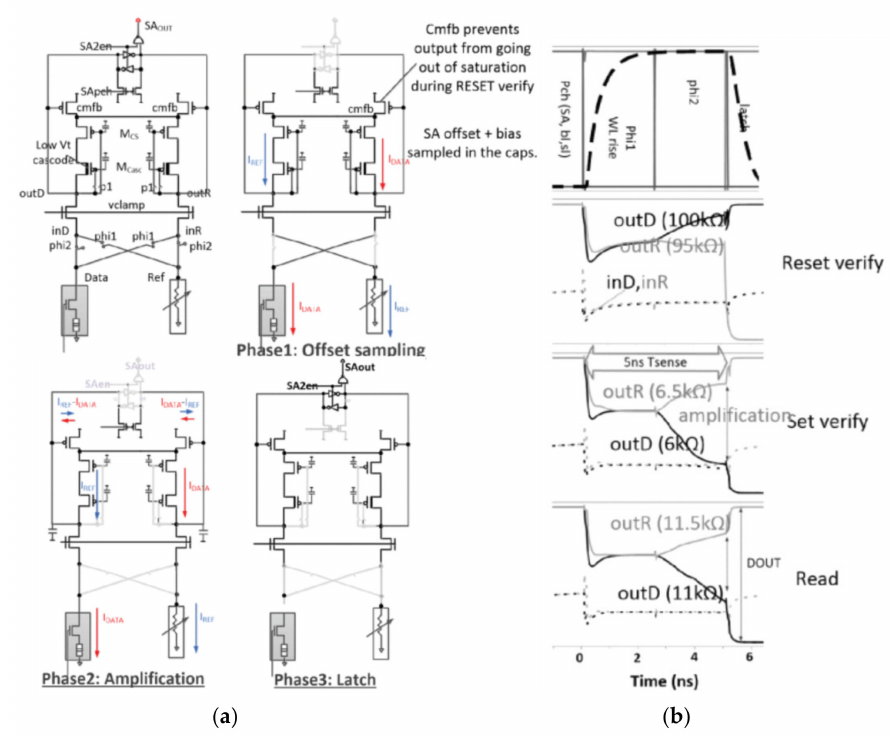
Figure 10. ( a ) OC-CSA in different phases; ( b ) example read, set, and reset-verify simulations [82]. In phase-1, phi1 is on, Idata flows through the path on the right, and Iref flows through the path on the left. Due to the diode connection mode, the current bias voltage and the offset voltages caused by the path are all sampled to the capacitors Mcs and Mcasc. In phase-2, phi1 is turned off and phi2 is turned on. Idata flows through the left path, and Iref flows through the right path, so the current flowing through the second-order latch sampling point is Idata-Iref and Iref-Idata. The difference is 2 × (Idata-Iref), and it also reduces the effect of the offset